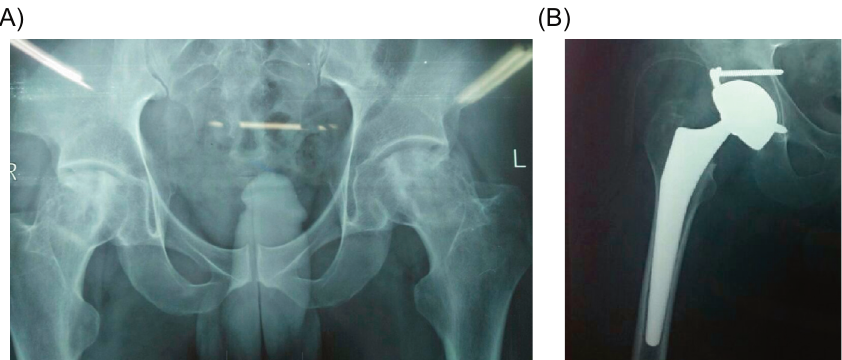
Figure 3. (A) Preoperative X-ray of a 57 year old male patient with bilateral hip arthritis due to AVN, (B) postoperative X-ray of the patient after cementless dual mobility THA with a good